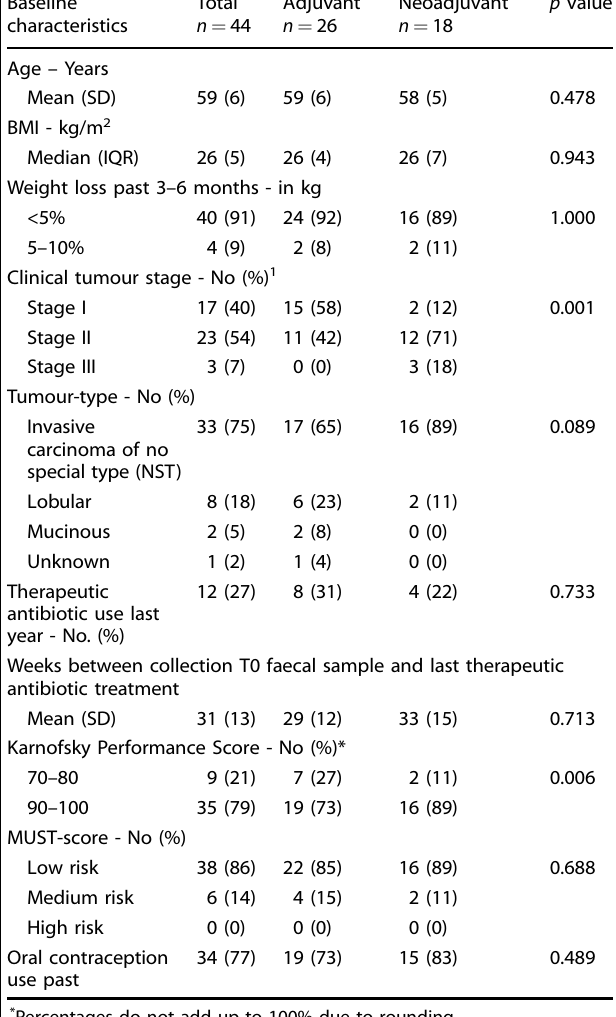
Table. 1. Clinical characteristics of the total study population ( N = 44) at baseline including the comparison between adjuvant- and neoadjuvant-treated